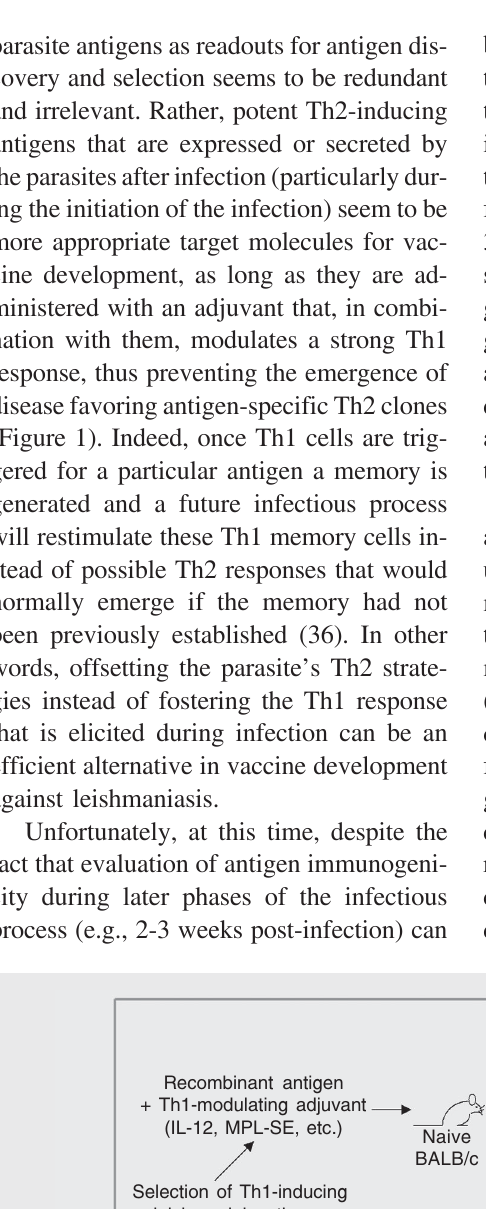
Figure 1. Schematic illustration of a common sense Th1 strat- egy (upper box) and an unortho- dox Th2 alternative protocol (lower box) of antigen discovery/ selection in vaccine develop- ment against cutaneous leish- maniasis. IL-12 = interleukin 12; MPL-SE = monophosphoryl lipid A plus